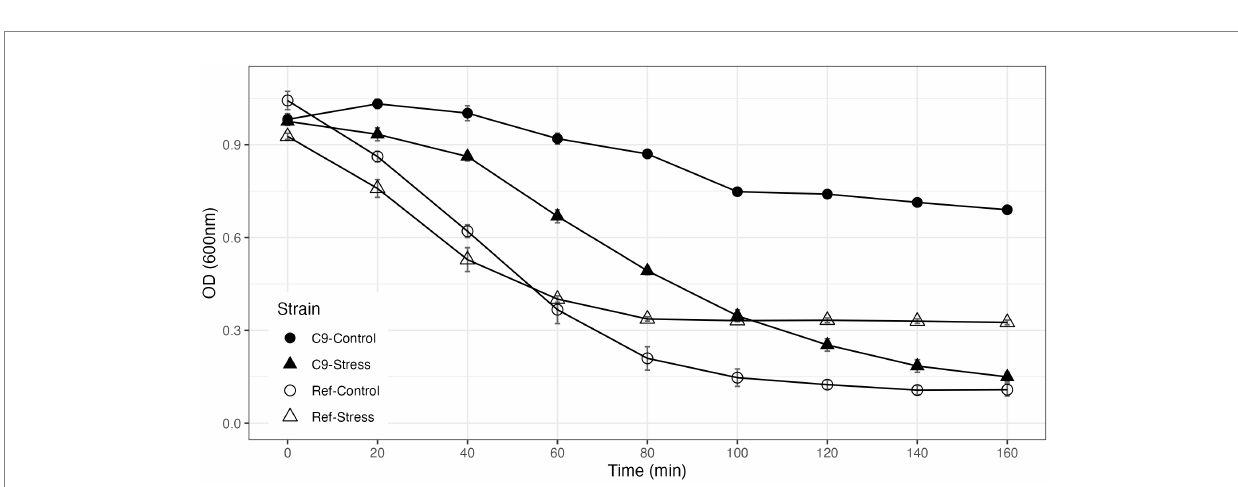
FIGURE 5 Lyticase sensitivity assay results of the reference strain (Ref) and the evolved strain under 3 g/L 2-phenylethanol stress and control conditions. Lyticase sensitivity was calculated as the percent decrease in lyticase resistance from 100% (the initial resistance